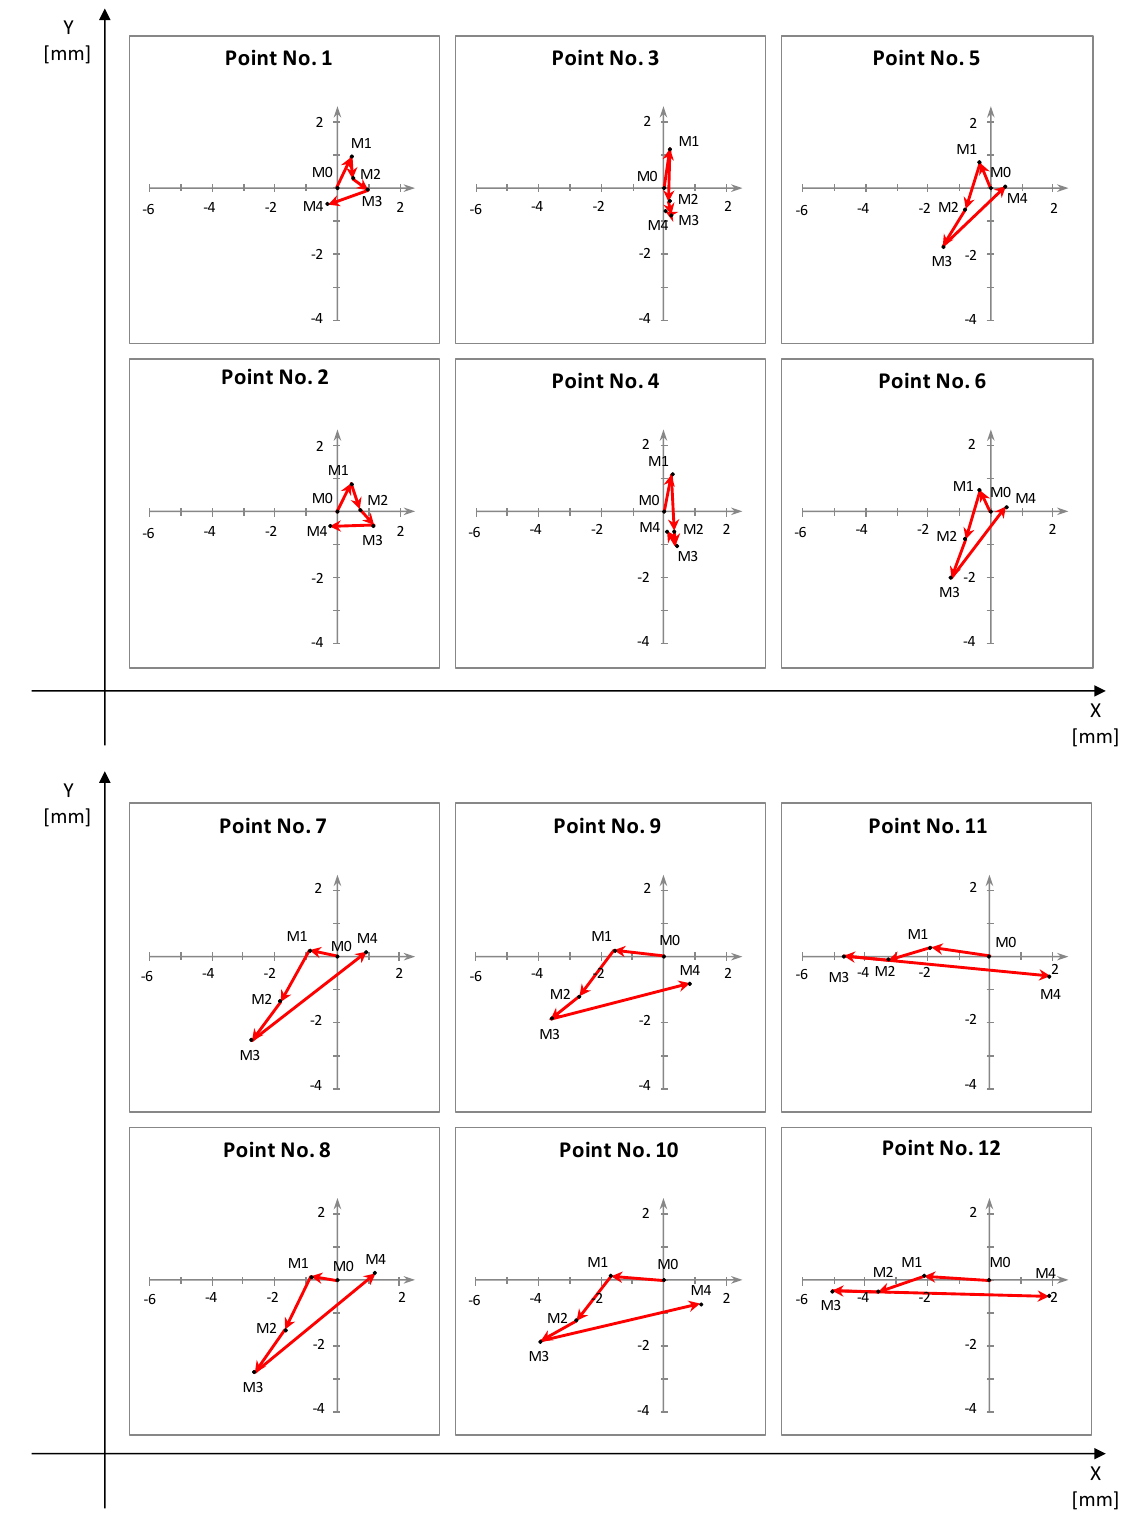
Figure 10. Horizontal displacements of top control points at di ff erent temperatures (measure terms), shown in Table 1.